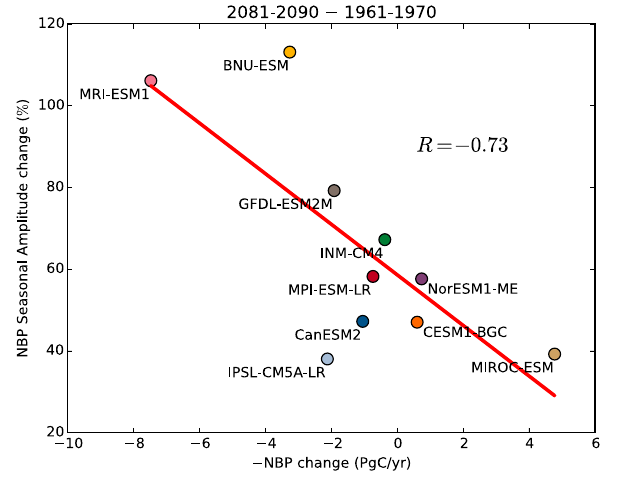
Figure 8. Relationship between − NBP change and increase of NBP seasonal amplitude, calculated as the differences between 2081–2090 and 1961–1970 for 10 CMIP5 ESMs. The negative cross-model correlation ( R = − 0 . 73, p < 0 . 05) suggests that a model with a larger net carbon sink increase is likely to simulate a higher increase in NBP seasonal